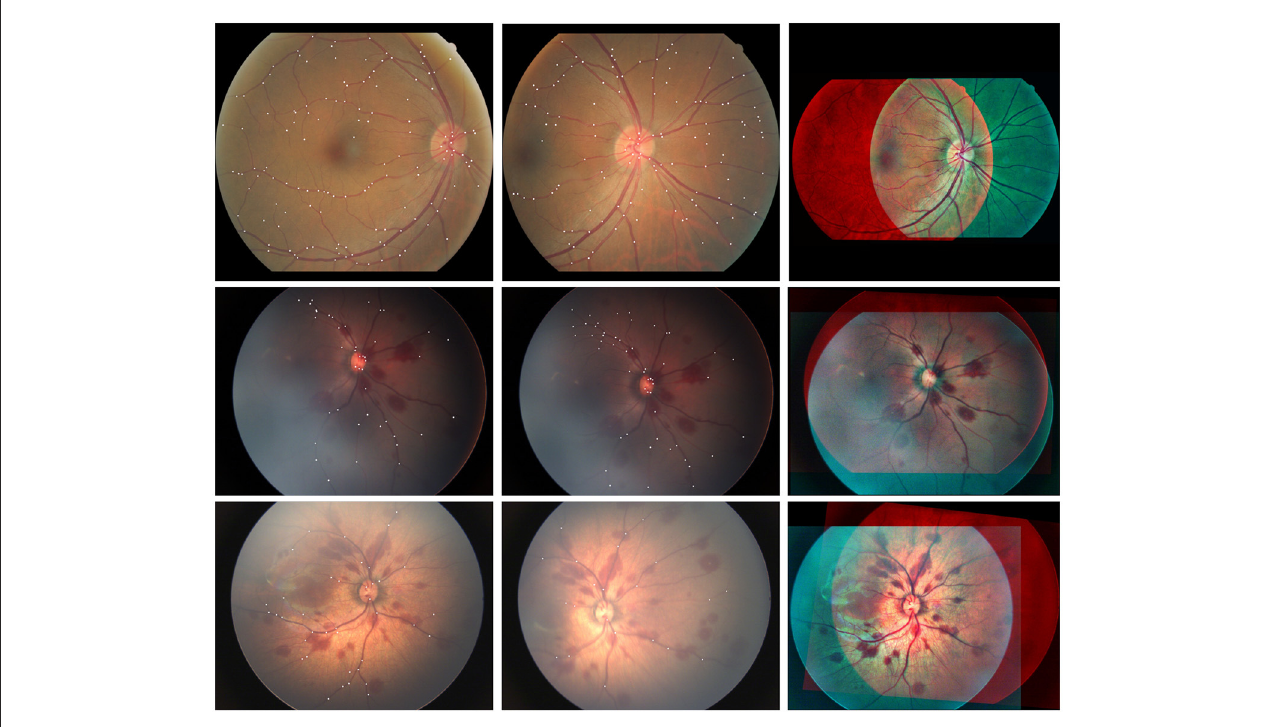
FIGURE5 Example of the fundus images from diverse applications, including adult and neonatus patients acquired under good or bad imaging conditions. Moreover, different imaging angles and overlapping areas between the image pairs are also considered.